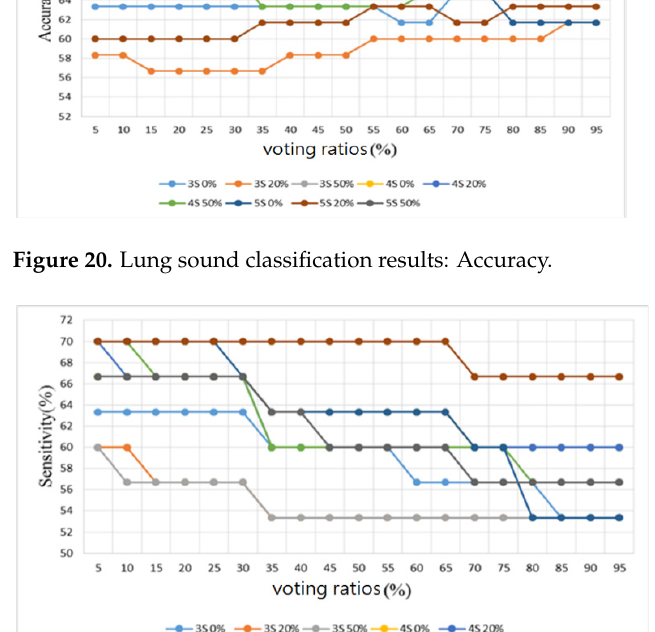
Figure 21. Lung sound classification results: Sensitivity.